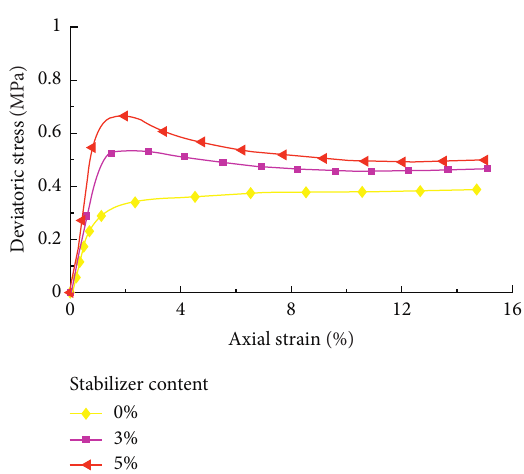
Figure 14: Influence of stabilizer content on deviatoric stress-axial strain relationship (confining pressure � 0.1MPa; curing time � 3 days).